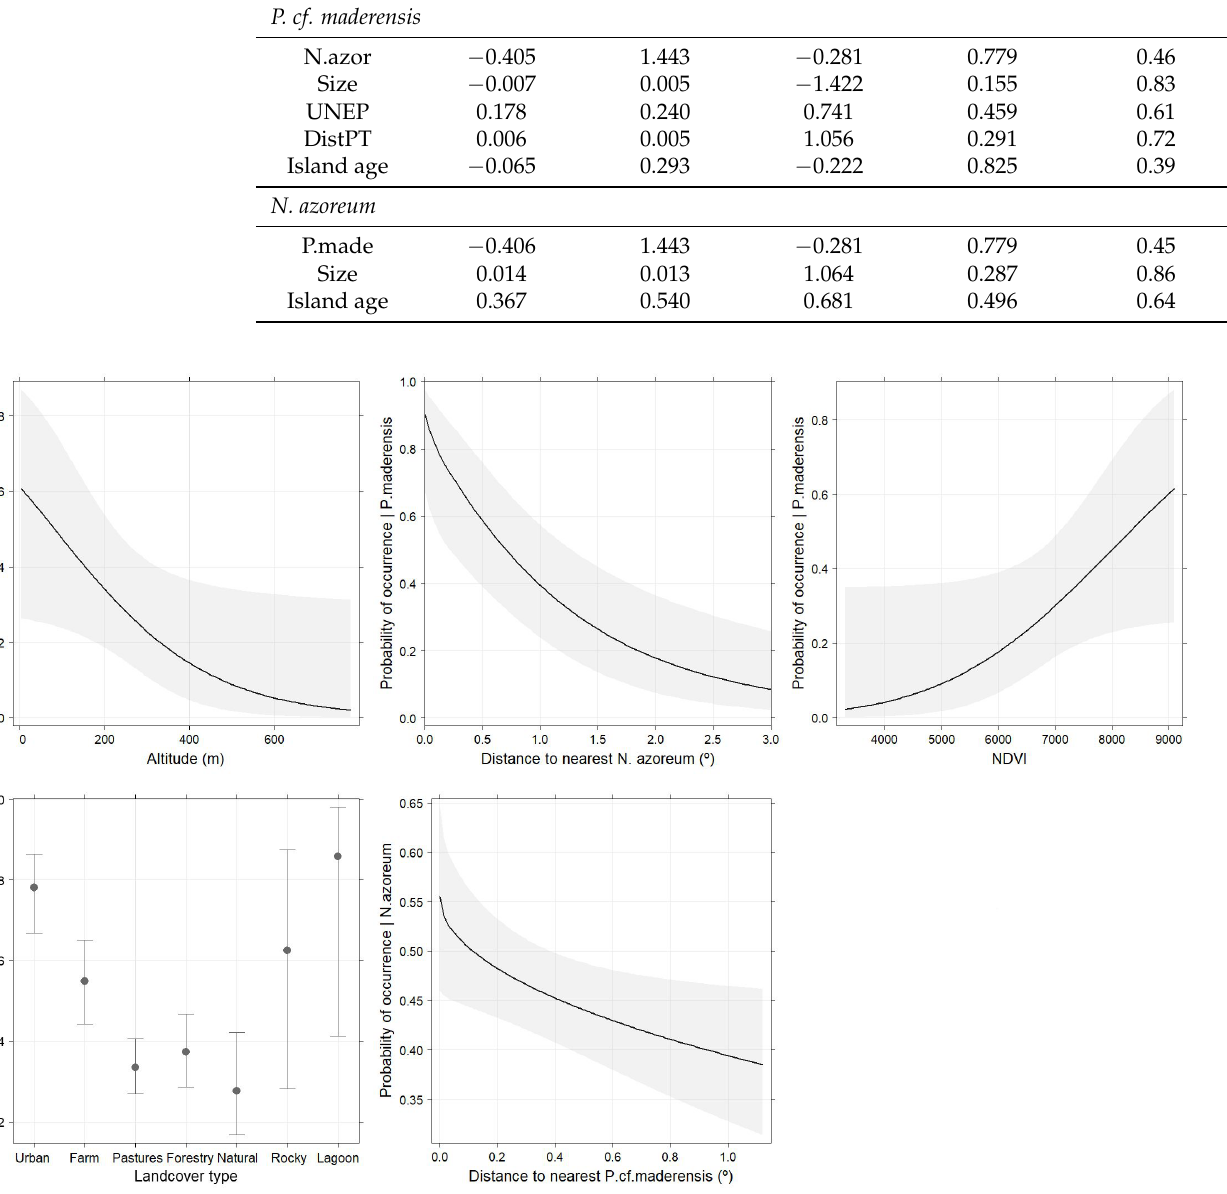
Figure 2. Binomial generalised linear models’ partial effects of altitude, distance to the nearest N. azoreum and NDVI on the probability of the occurrence of P. cf. maderensis (top row) and land-cover and distance to the nearest P. cf. maderensis on the probability of the occurrence of N. azoreum (bottom row). Error bars and shaded areas represent 95 confidence